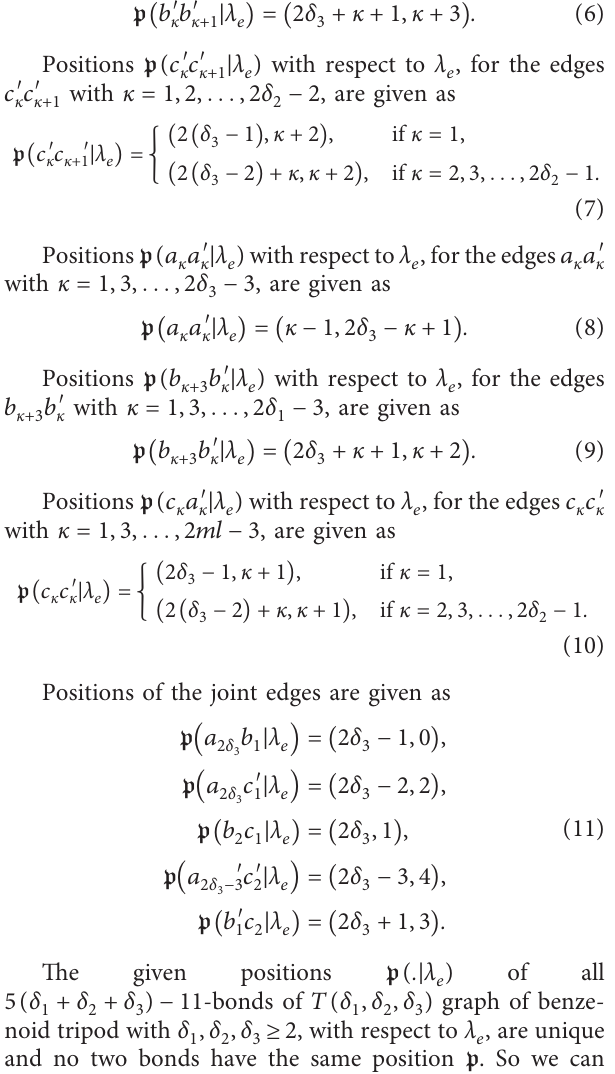
, δ , δ 􏼈 􏼉 � 3 , 3 , 4 { } 1 2 3